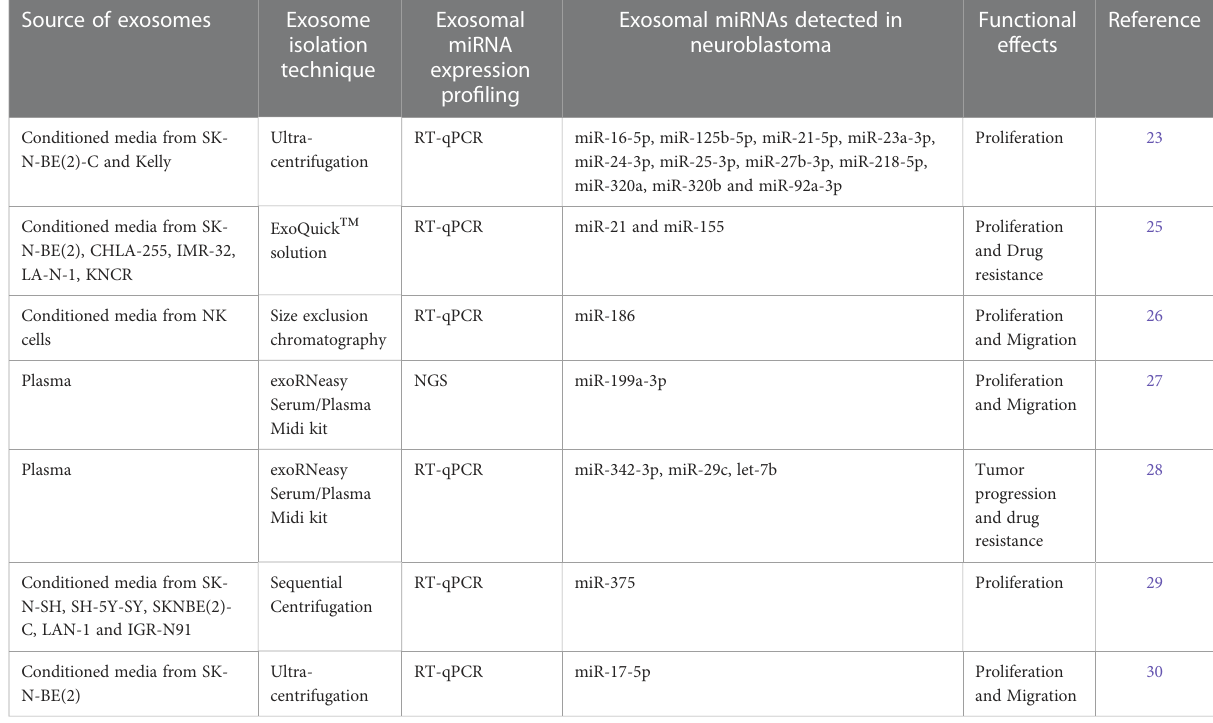
TABLE 1 The articles investigating the role of exosomal miRNAs (exo-miRs) in neuroblastoma. Source of